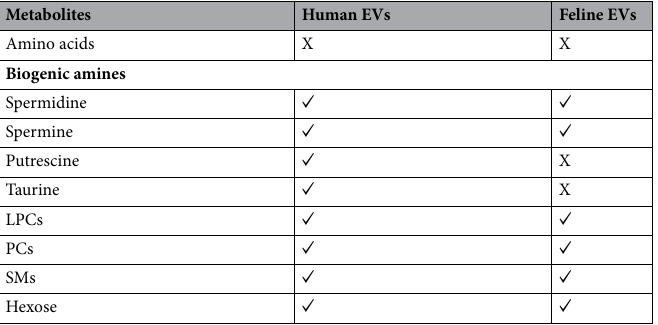
Table 2. Identification of metabolites in human and feline EVs. Amino acids were not detectable in the current samples analysed. Four biogenic amines, spermidine, spermine, putrescine, and taurine were identified in human EVs, and spermidine and spermine were also identified in feline EVs. Many lipids such as LPCs, PCs, and SMs and the sum of hexose were identified in both human and feline EVs. The detailed metabolites identified in human and feline EVs are listed in the supplementary information (Supplementary Information: Sect. 5). X < limit of detection. ✓ > limit of detection. LPCs lysophosphatidylcholines, PCs phosphatidylcholines, SMs